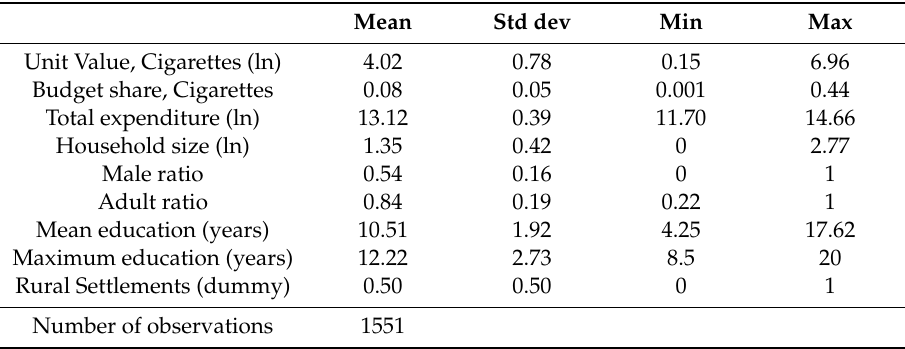
Table 1. Descriptive statistics of variables